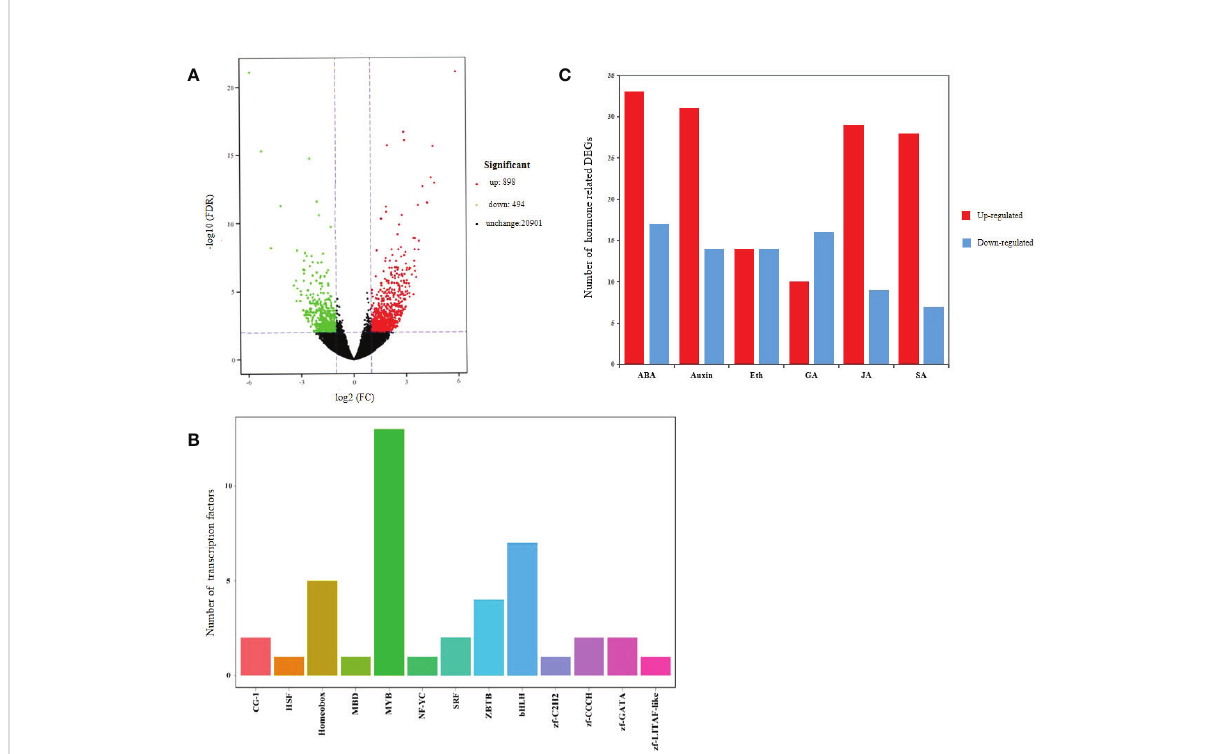
FIGURE 8 Transcriptome analysis of transgenic and WT alfalfa. Volcano plot of DEGs (A) . In graphs, each plot represents one gene with three colors, including red (up-regulated), green (down-regulated) and blank (unchanged). The X-axis represents the value of log 2 (Fold Change) in the two samples, and the Y-axis indicates the negative value of log 10 (FDR). Differentially expressed transcription factor genes identi fi ed with MsSAG113 overexpression (B) . In graphs, the X-axis represents transcription factor family, and the Y-axis represents the number of transcription factor genes. Hormone related DEGs (C) . Eth indicates Ethylene. Red indicates up-regulated, and blue indicates